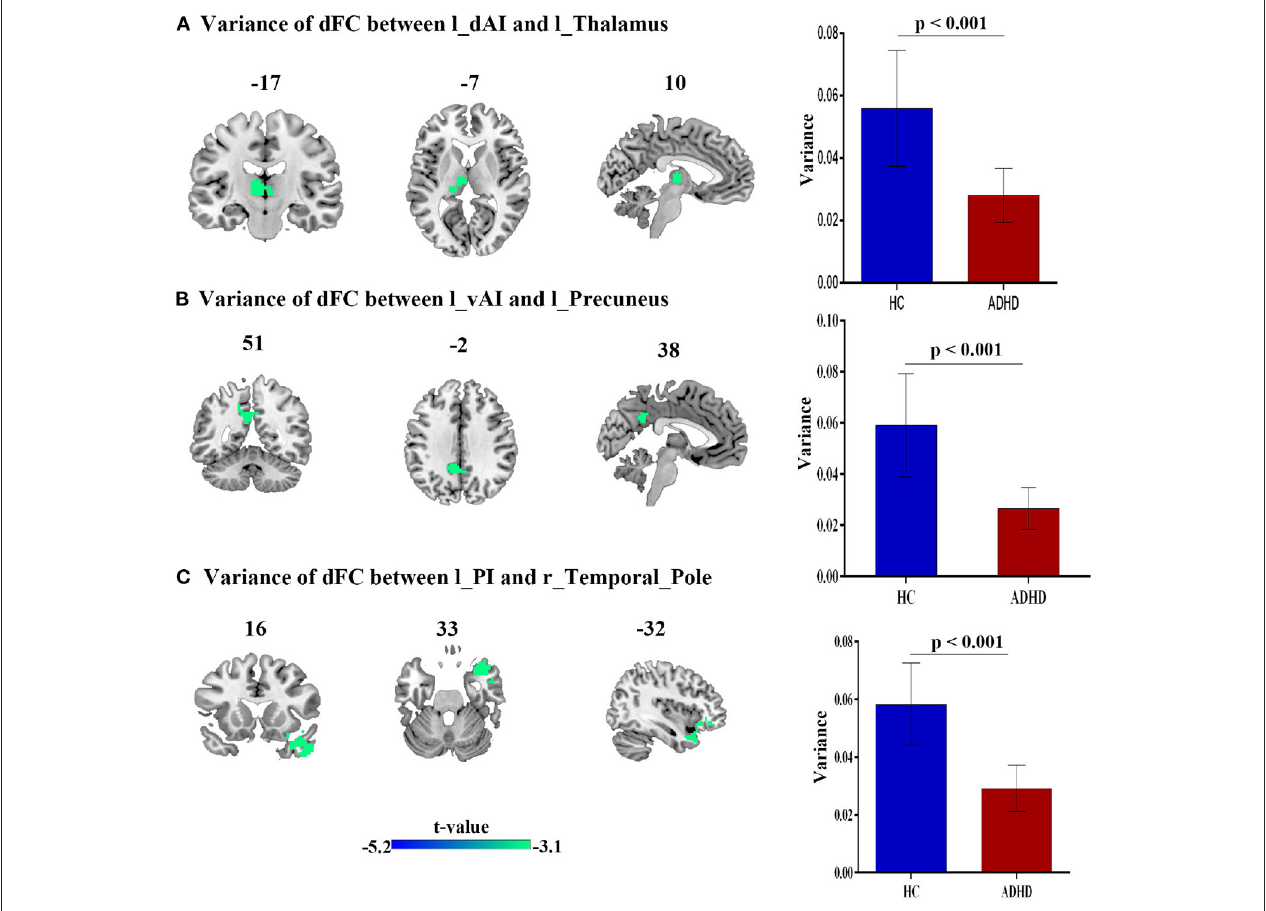
FIGURE 3 | The variance of dFC between the left insula and other brain regions, obtained by comparing HCs and ADHD groups, using two sample t -test; (A) Between left dAI and Left thalamus. (B) Between left vAI and left precuneus, (C) between left PI and right temporal_pole_mid.